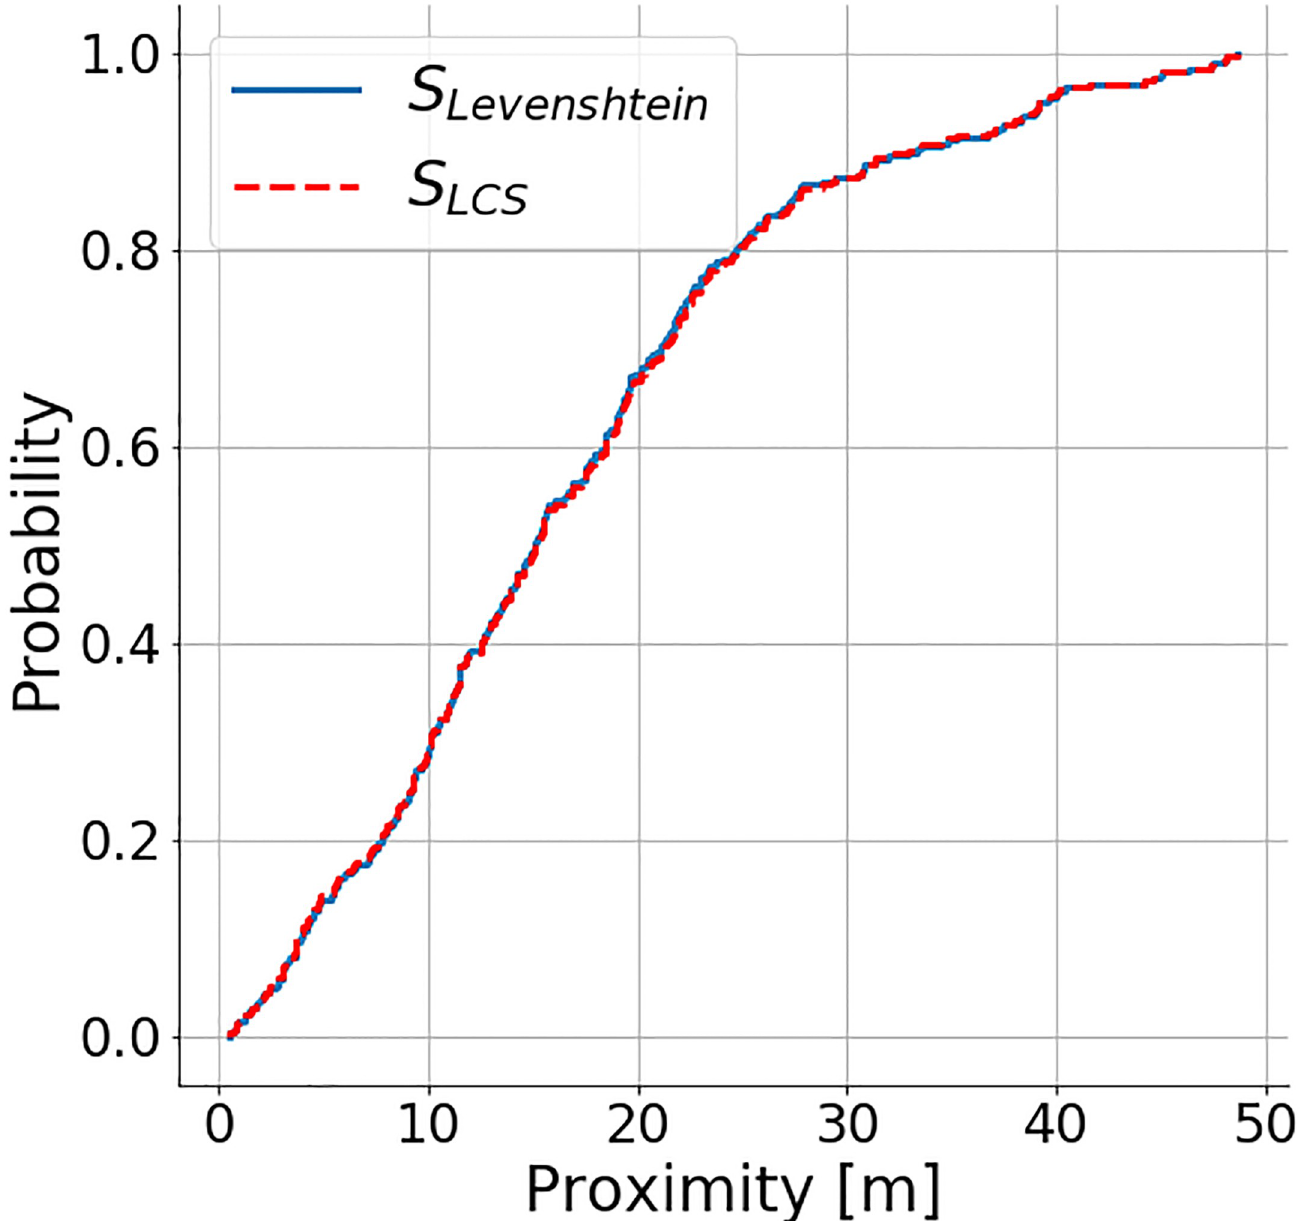
Fig 14. CDF of proximity ( S LCS , S LD � 0.9, proximity threshold � 50 m ).